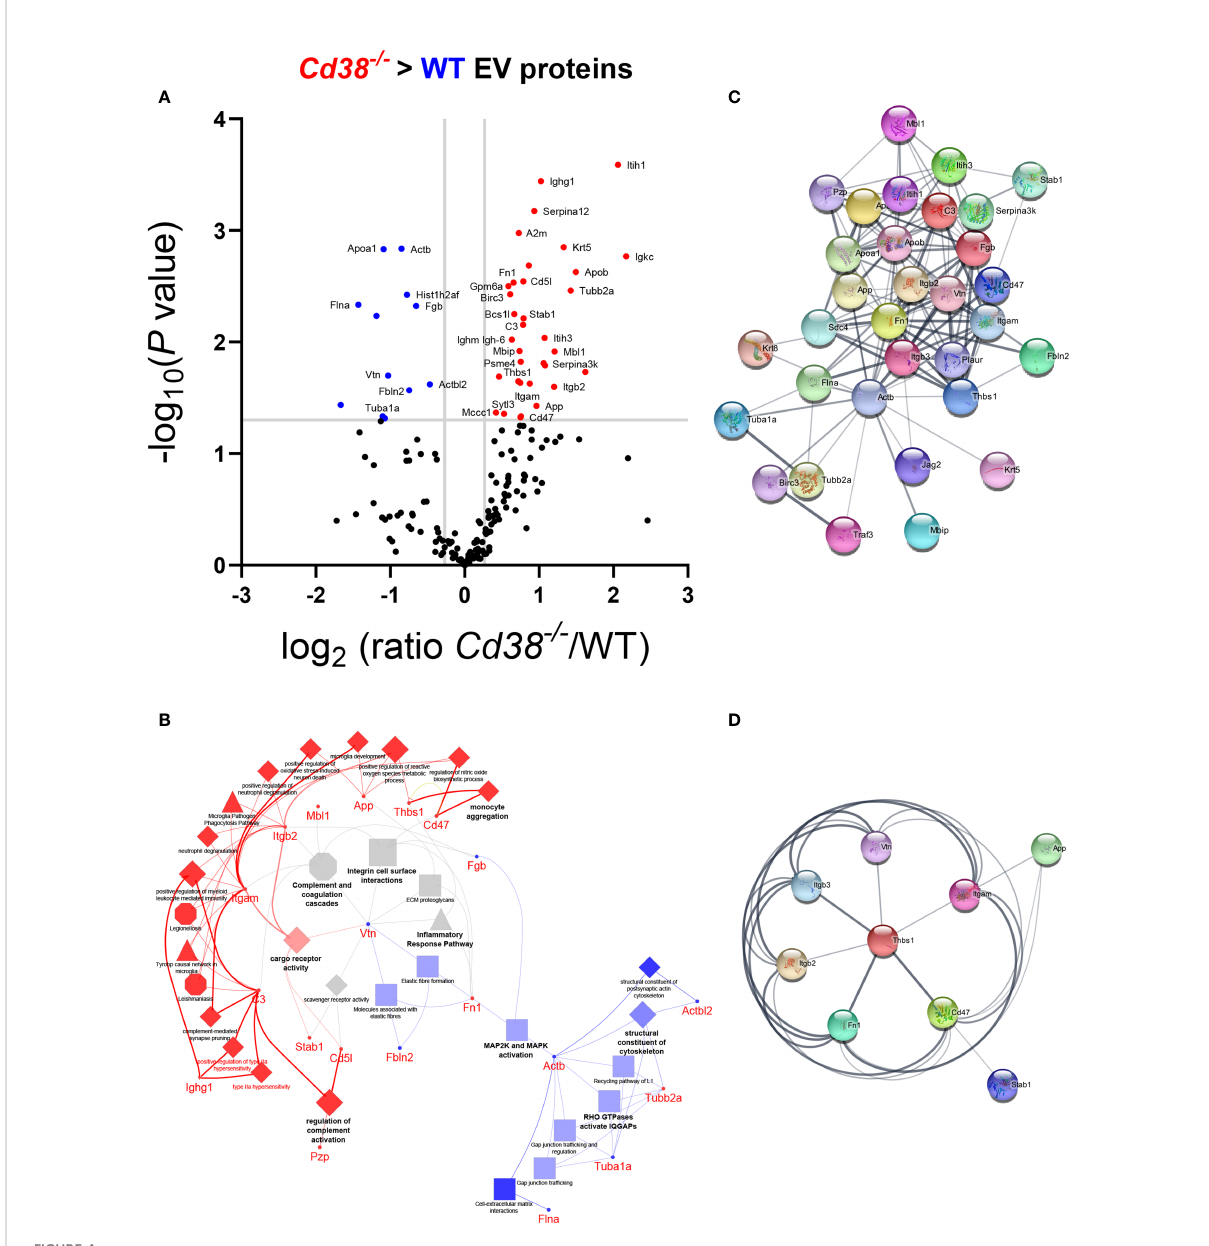
FIGURE 4 (A) Volcano plot of the common proteins to F5-12 Cd38 -/- EV and F5-12 WT EV. The grey horizontal line separates the statistically signi fi cant proteins with a pV < 0.05 from the non-signi fi cant proteins. Vertical grey lines are indicative of the absolute 1.3 fold-change limit. Red dots indicate proteins in Cd38 -/- EV with an absolute abundance greater than 1.3 and pV < 0.05. Blue dots indicate proteins in WT EV with an absolute abundance greater than 1.3 and pV < 0.05. Black dots are the proteins with no statistically signi fi cant differences. The gene names of the proteins with signi fi cant increased abundance is shown. (B) Network of GO terms and signaling pathways generated from the list of 46 common proteins to F5-12 Cd38 -/- and F5-12 WT EV that showed signi fi cant increased abundance in the Volcano plot of panel (A) . Two protein lists (clusters) were compared: Proteins with increased abundance in Cd38 -/- EV (cluster #1) versus proteins with increased abundance in WT EV (cluster #2). The network has been created using the ClueGO and Cluepedia applications of Cytoscape 3.9.0, with the ontologies GO Biological Process, Immune System Process, Molecular Function, KEGG, REACTOME Pathways and Wiki Pathways; pV < 0.05. From the 2 proteins clusters that were compared, 3 categories of functional terms were generated: terms and genes speci fi c for F5-12 Cd38 -/- EV (red), terms and genes speci fi c for F5-12 WT EV (blue), and common terms (grey). The node size is indicative of the term statistical signi fi cance. Terms or pathways are considered speci fi c for a given cluster when >60% of the proteins are originating from one of the clusters. The terms with the highest statistical signi fi cance within each functional group are highlighted in bold and de fi nes the name of the functional group. Gene names instead of protein names or Uniprot IDs are shown in ClueGO and String apps by default. (C) Network of protein-protein interactions created with 35 out of the 46 proteins showing signi fi cant increased abundance in either F5-12 Cd38 -/- EV or in F5-12 WT EV. This network has been created with the StringApp within Cytoscape with an interaction con fi dence score of 0.4. (D) First protein neighbors interacting with CD47. All these proteins showed increased abundance in Cd38 -/- EV relative to WT